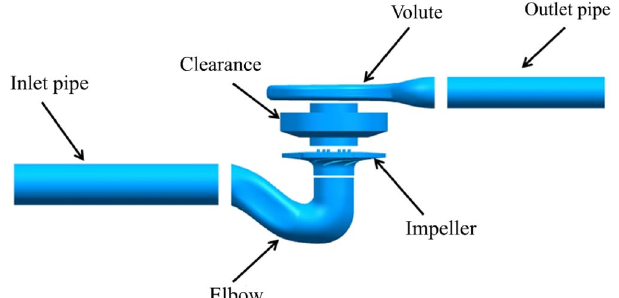
Figure 1. Entire flow field model.